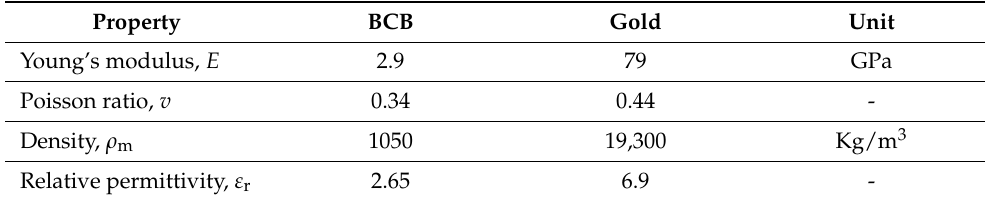
Table 4. Material properties [25].